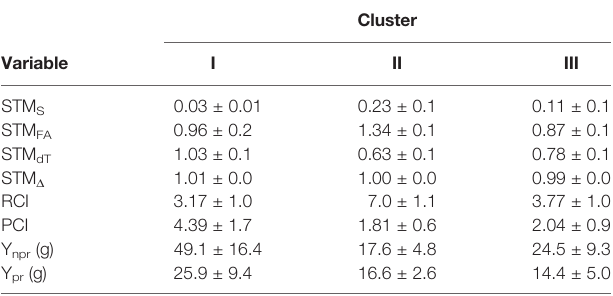
TABLE 4 | Average value ± standard error of STM traits, drought tolerance indices and total biomass production for each cluster (I, II and III) from Principal Component